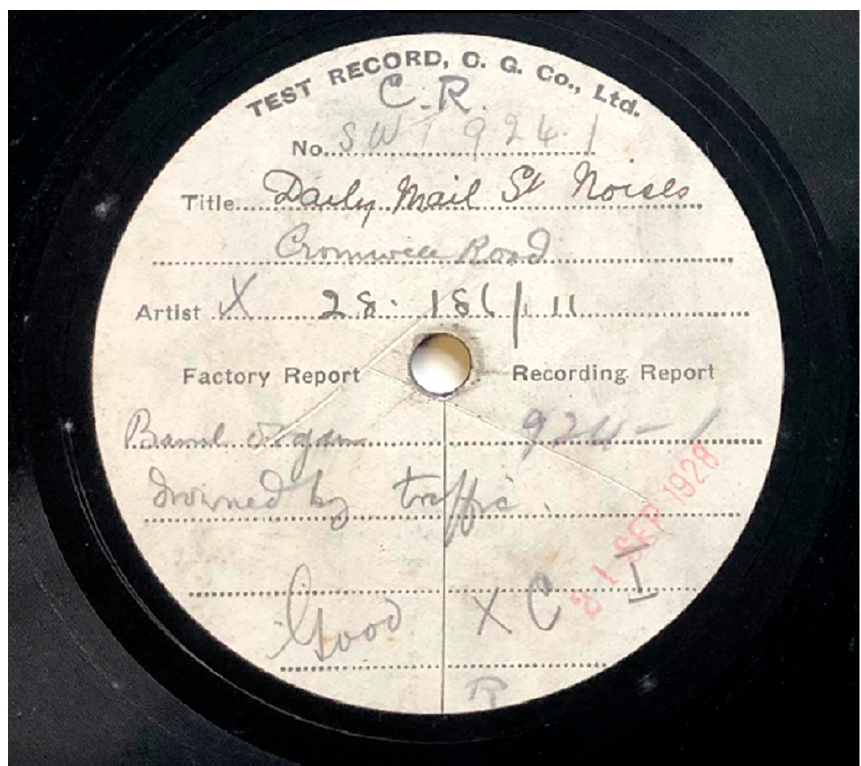
Figure 3. Cromwell Road LSN record label.